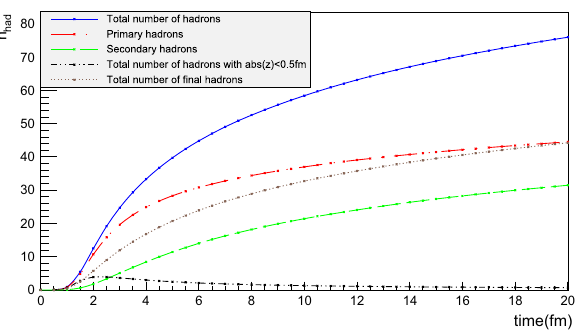
Fig. 19 Hadron number per event as a function of time, up until t = √ s = 13 TeV 20 fm, for pp collisions at